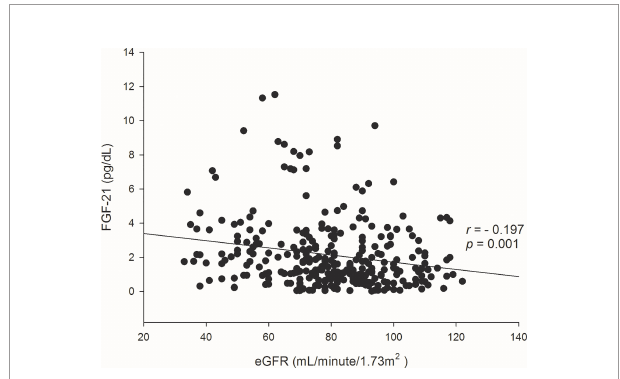
FIGURE 2 | Scatter plots and correlation ef fi cient ( r ) of the concentrations of FGF-21 and eGFR levels at